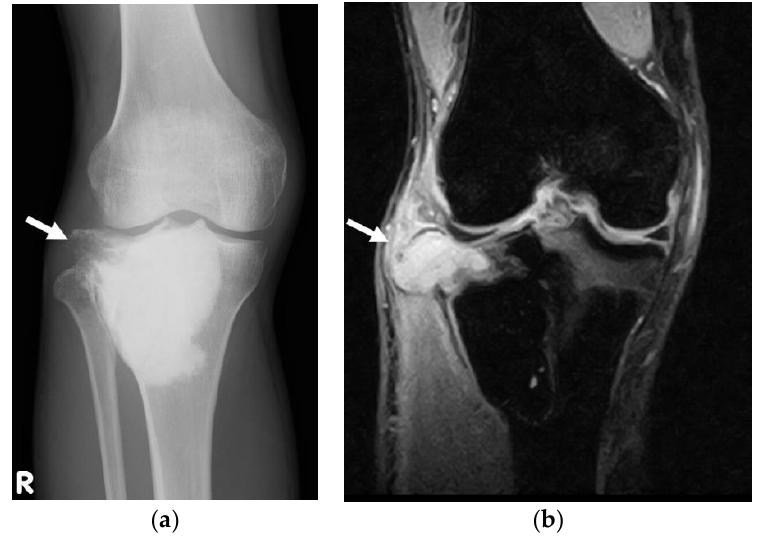
Figure 3. A patient with secondary malignant giant cell tumor of the proximal tibia who experienced malignant transformation after the third episode of local recurrence 6 years after the initial inversion recovery. ( a ) Radiograph shows a lytic lesion at lateral side of the proximal tibia (arrow). ( b ) The coronal fat-suppressed T2 W magnetic resonance image shows a high-intensity extraosseous lesion corresponding to a Campanacci stage 3 tumor (arrow).